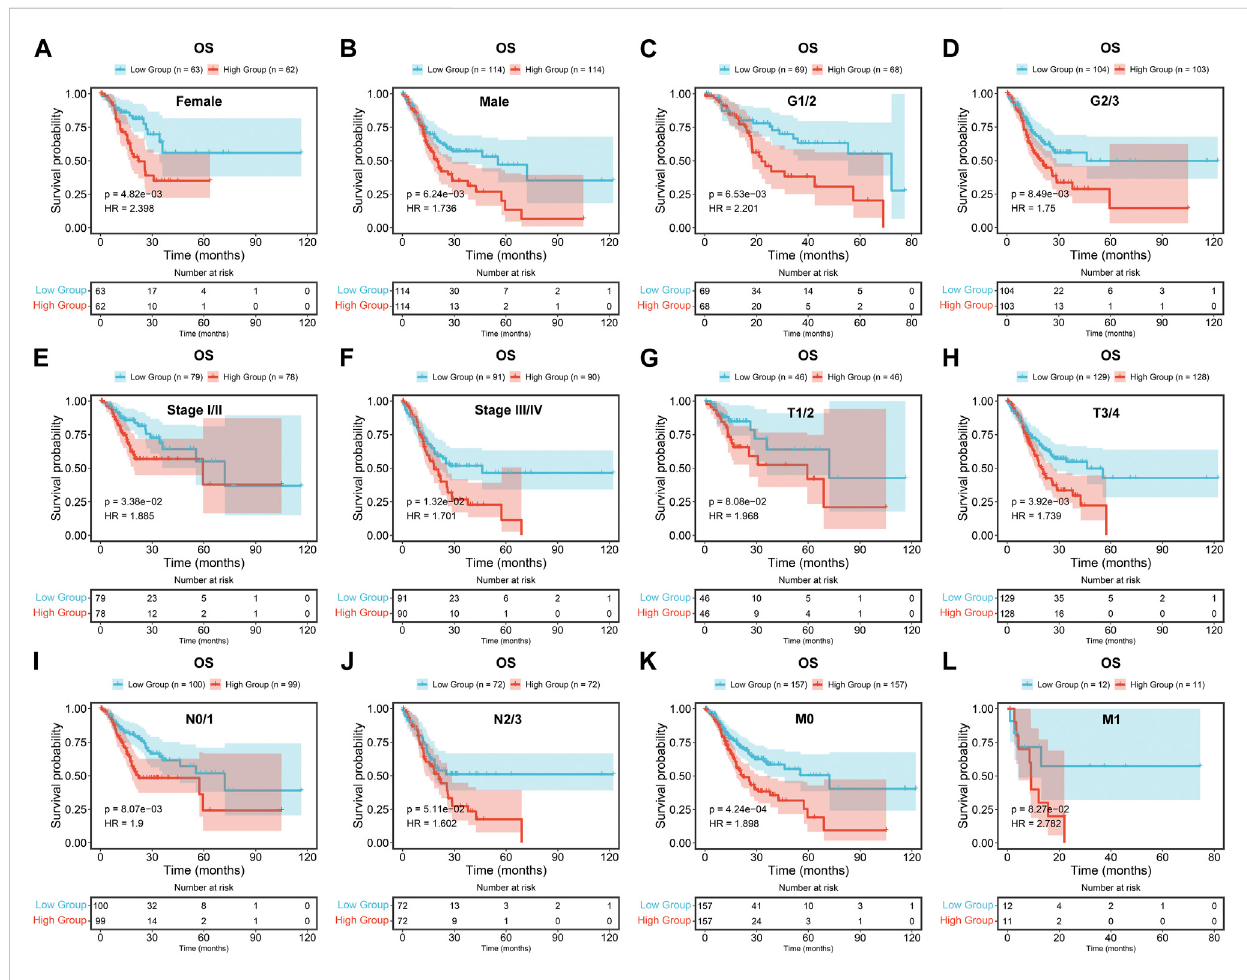
FIGURE 6 Subgroup analysis of the DNA damage repair-relevant signature in survival prediction in the TCGA-STAD dataset. (A – L) Prognostic differences of low- and high-risk patients in each subgroup strati fi ed by conventional clinical parameters: sex, grade, stage, T, N, and